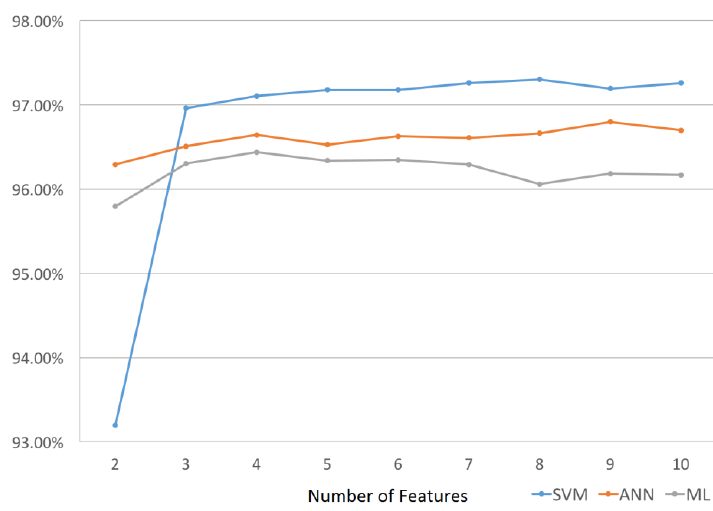
Figure 4. Classification accuracy achieved by three classifiers with the number of features changing from 2–10.